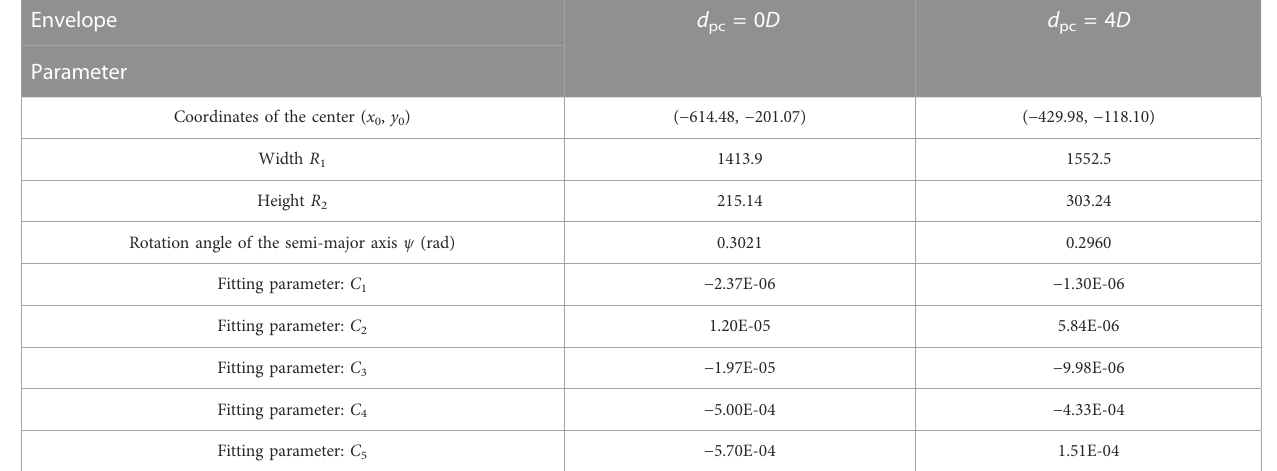
TABLE 2 Fitting results for the failure envelope of bearing capacities of single piles near slopes.